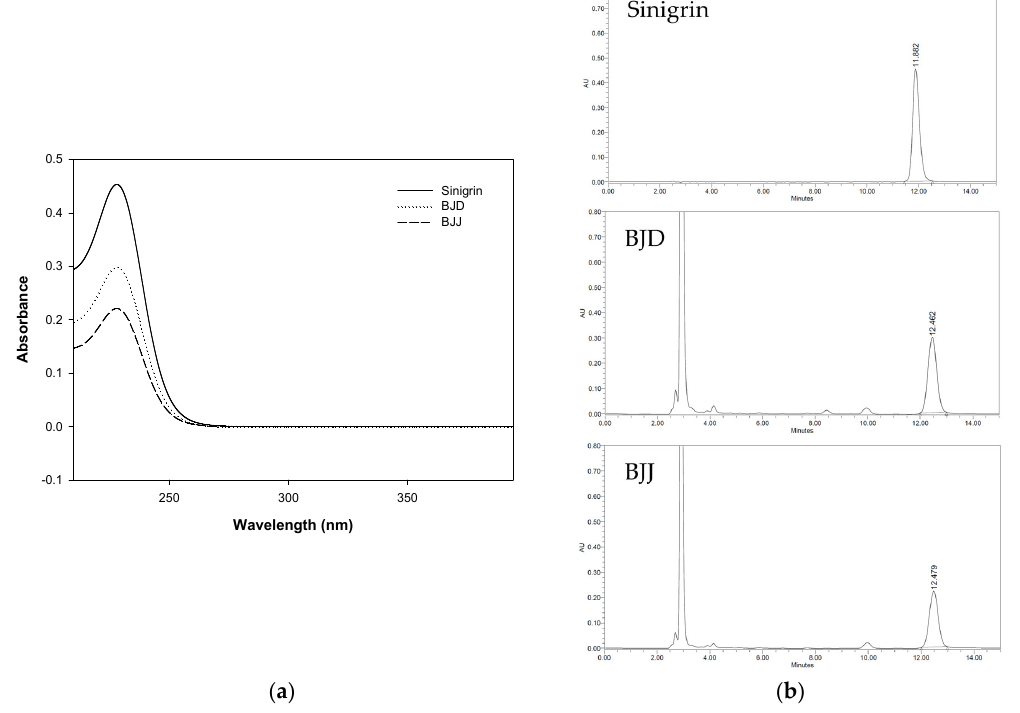
Figure 3. ( a ) PDA spectrums and ( b ) HPLC chromatogram of sinigrin, BJD and BJJ.